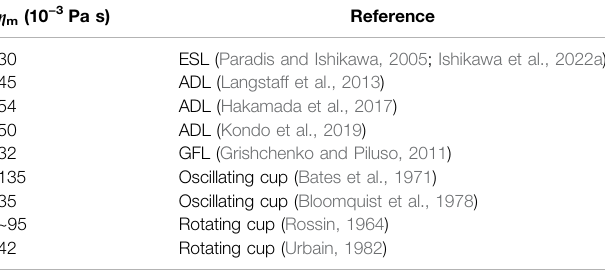
TABLE 3 | Viscosity of molten Al 2 O 3 at its melting